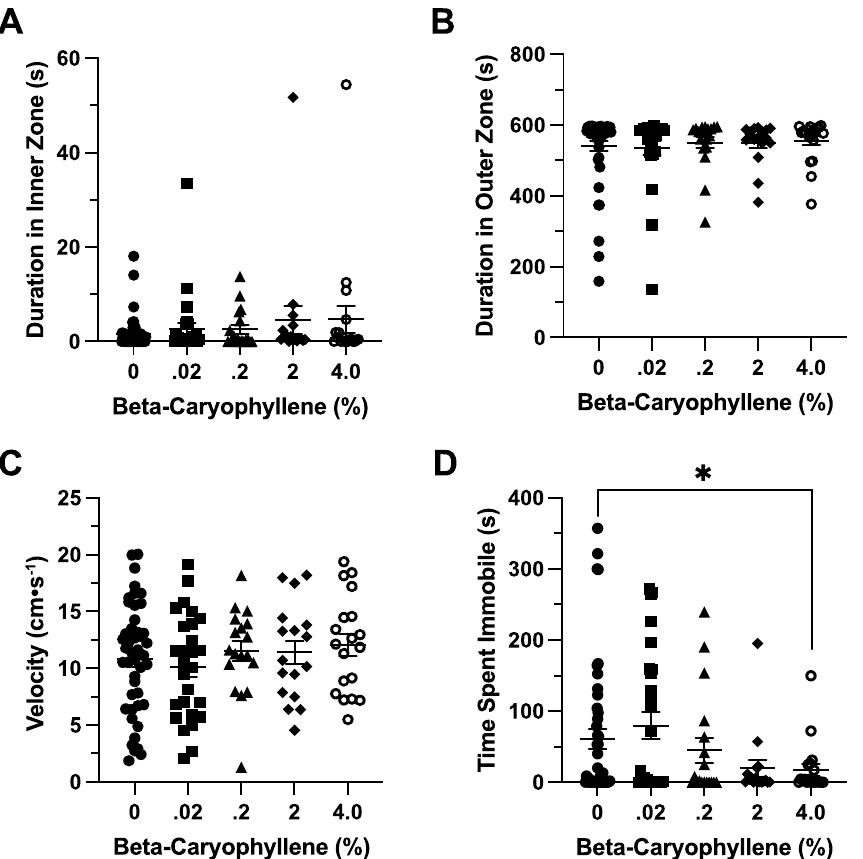
Figure 9. The effects of beta-caryophyllene administration in the novel object approach test. Average duration of time fish spent in the ( A ) inner and ( B ) outer ‘thigmotaxis’ zone during the novel object approach test. Fish locomotion was quantified in the novel object approach test by measuring ( C ) swimming velocity and ( D ) time spent immobile. All data are presented as mean ± S.E.M. Significant differences between controls and beta- caryophyllene treated groups are indicated by *( p <